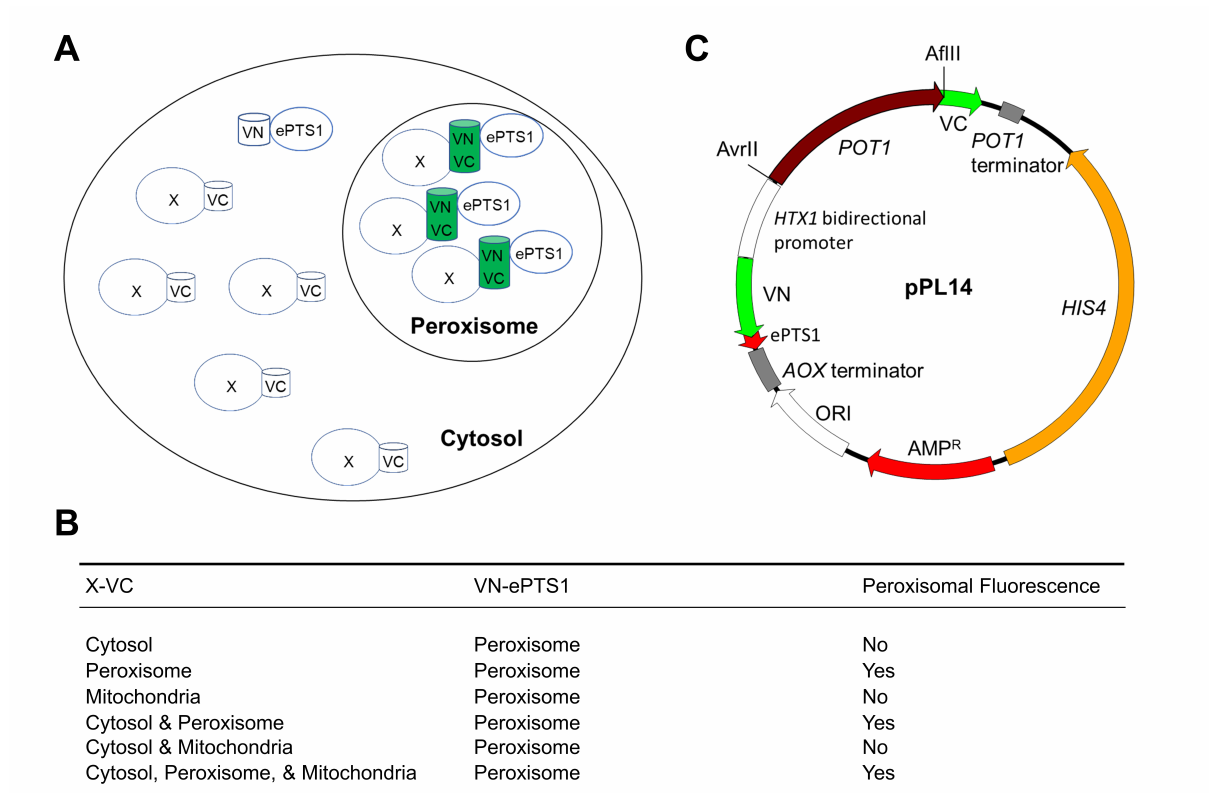
Figure 2. Expected fluorescence using the divergent BiFC assay. ( A ) Schematic representation of the expected outcome of the assay. ( B ) Potential subcellular localizations that may yield peroxisomal fluorescence. ( C ) Plasmid construct (VN and VC—BiFC moieties, POT1 and AOX terminator—transcription terminator, HIS4— histidine selection marker for yeast, Amp R —ampicillin resistance gene, HTX1 bidirectional promoter—strong constitutive bidirectional promoter, ePTS1— enhanced peroxisomal-targeting signal 1, POT1 —thiolase open reading frame, ORI—bacterial replication origin). AvrII and AflII were used for double digestion to replace POT1 with the gene encoding the protein of